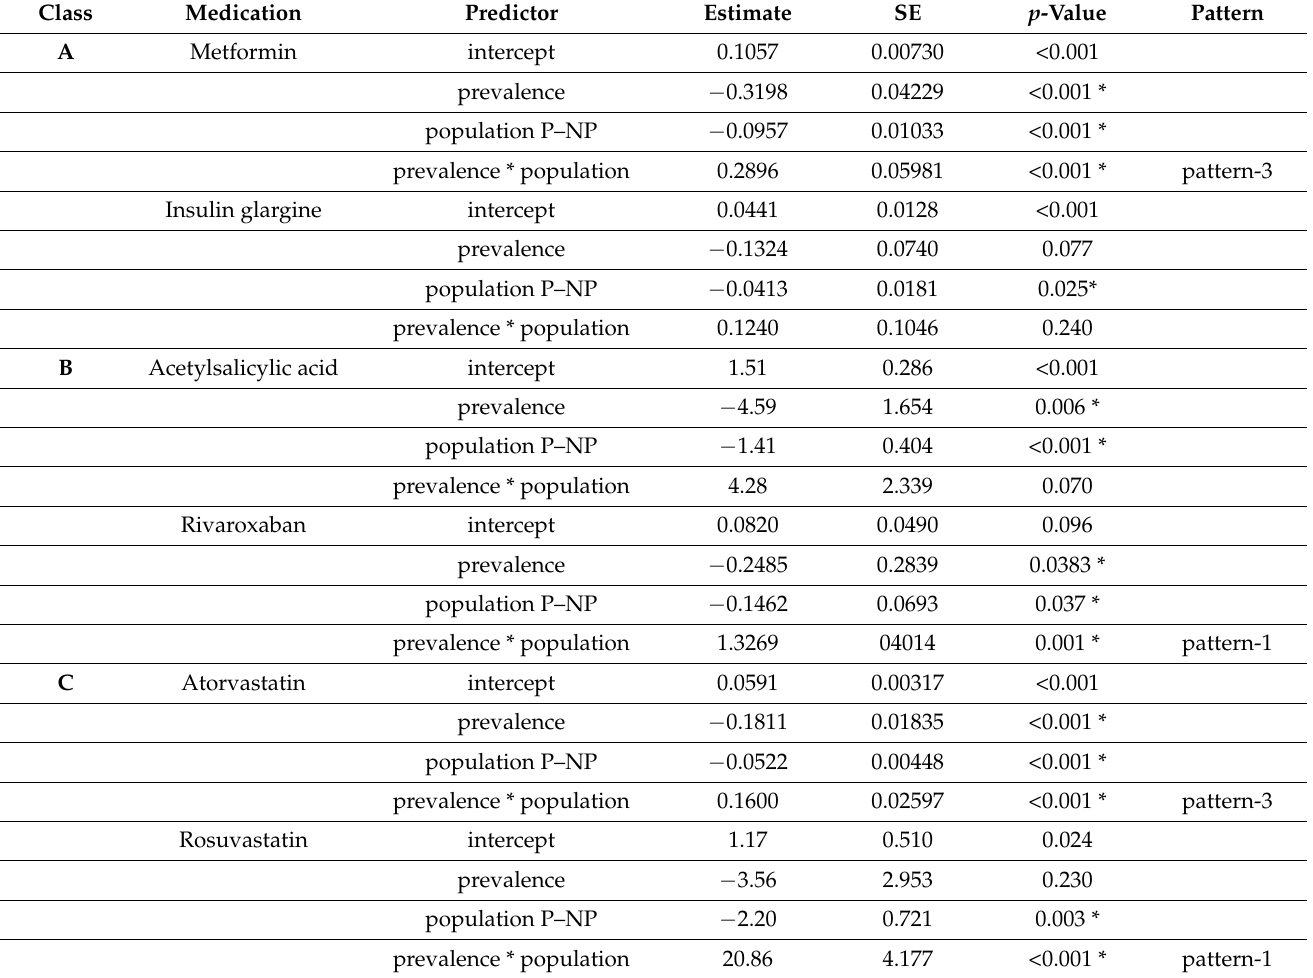
Table 3. Results of the linear regression analyses computed for each